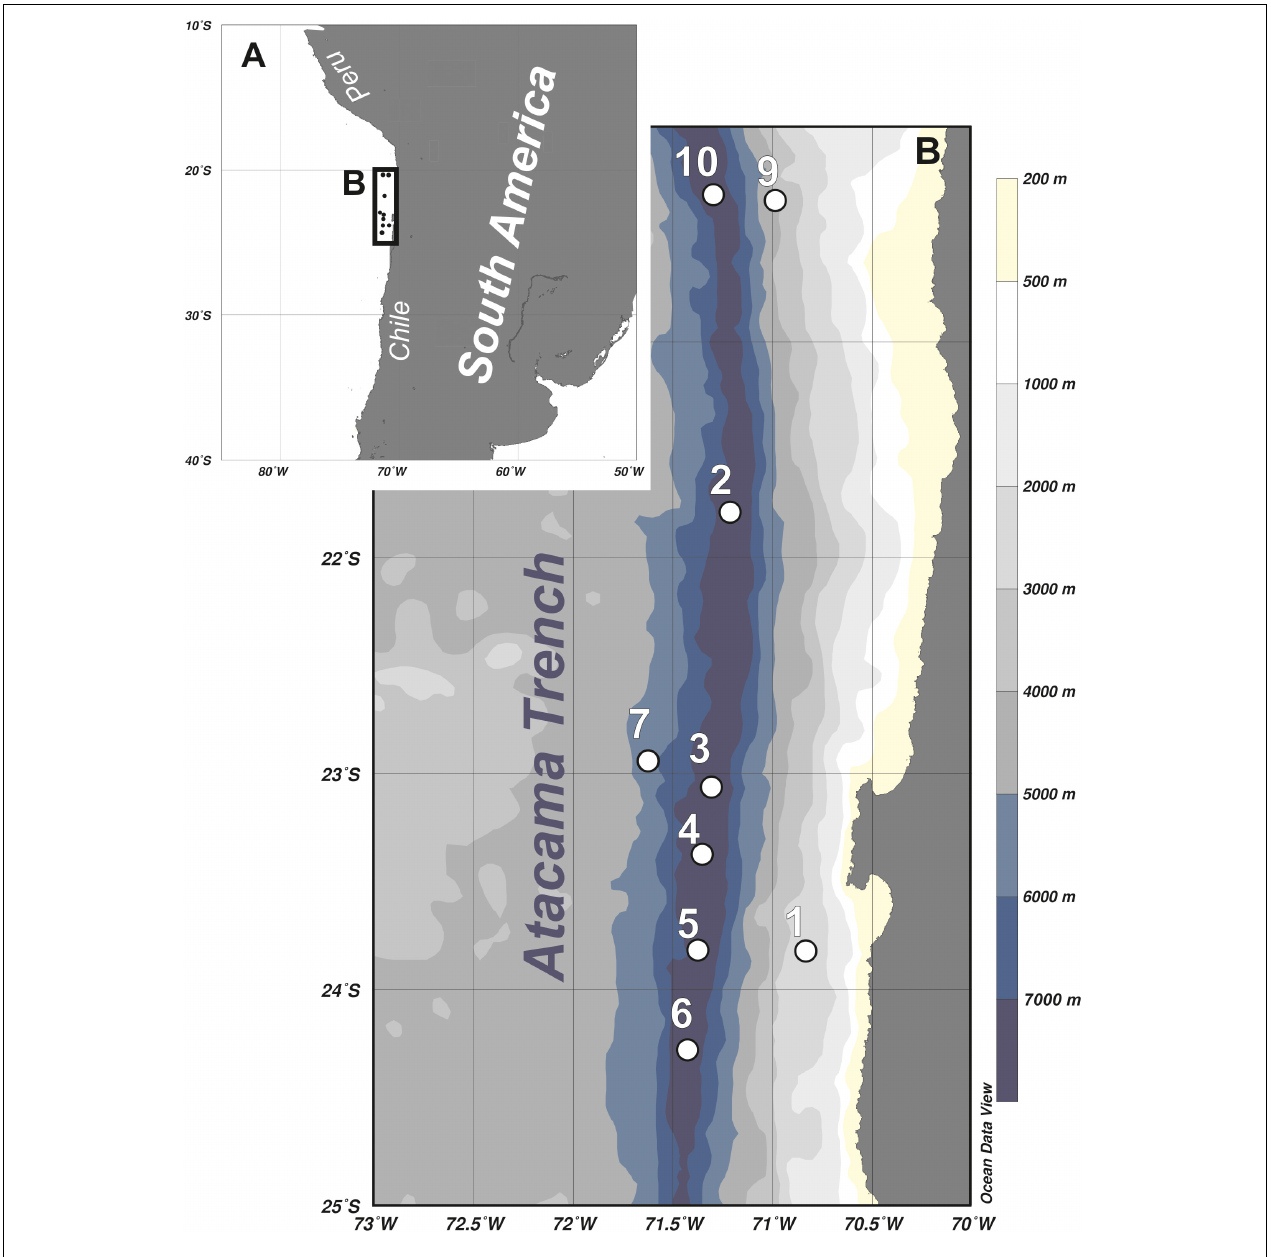
FIGURE 1 | Maps showing location of the Atacama Trench area (A) and detailed overview of the sampling stations (B)